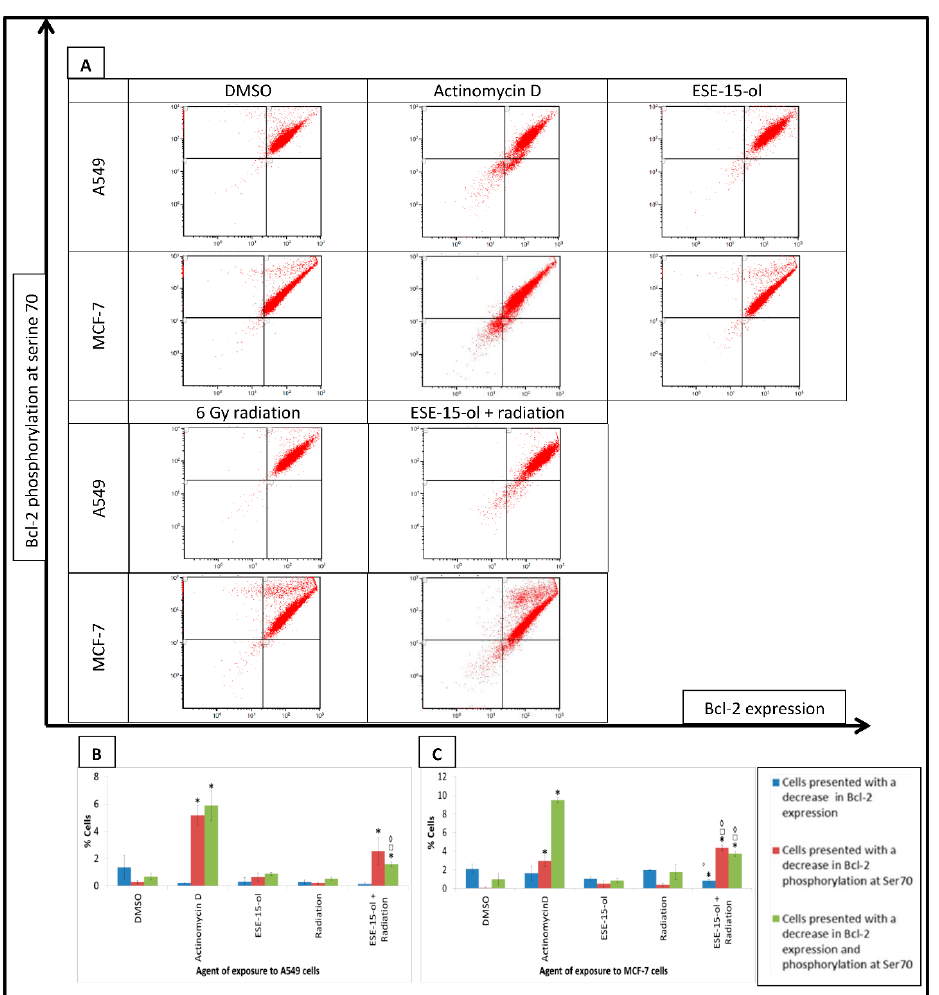
Figure 7. Flow cytometric analysis of Bcl-2 expression and -phosphorylation measured in exposed A549- and MCF-7 cells. ( A ) Fluorescence of FL1 (Bcl-2 expression) was plotted against FL3 (pBcl-2, Ser70). Dot plots of A549- and MCF-7 cells exposed to ESE-15-ol for 24-h, 6 Gy radiation and the combination treatment condition. Treated A549- and MCF-7 cells presenting with a decreased Bcl-2 expression and -phosphorylation were significantly increased when compared to DMSO. Presensitized A549- and MCF-7 cells displayed an increased number of cells with decreased Bcl-2 expression and -phosphorylation when compared to individual treatment conditions as shown in the graphical representations of A549 dot plots ( B ) and MCF-7 dot plots ( C ). Bars indicate average of three biological repeats, with standard deviation represented by T-bars. Statistical significance ( p -value < 0.05) represented by * when compared to DMSO, (cid:3) when compared to ESE-15-ol treated samples, ♦ when compared to radiation treated